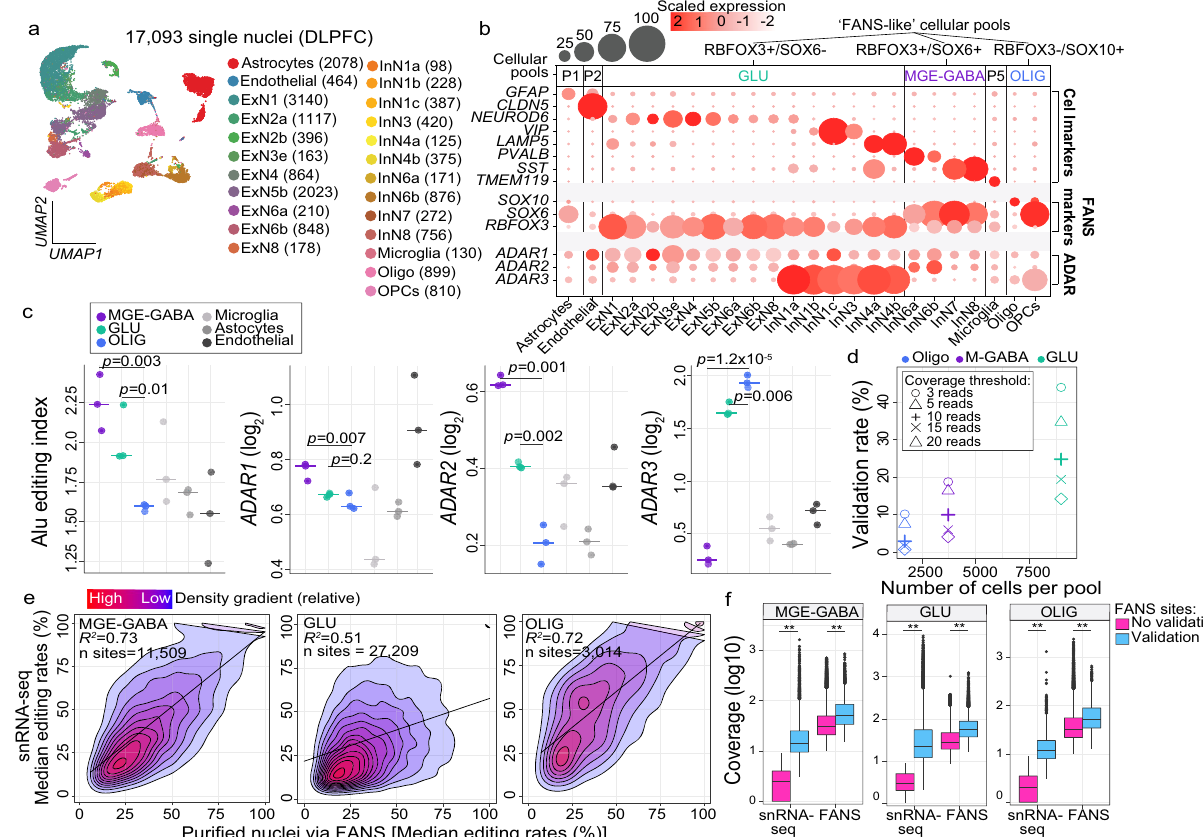
Fig. 4 Con fi rmation of cell-speci fi c editing in snRNA-seq. a snRNA-seq performed on adult PFC ( n = 3 biologically independent samples) classi fi ed 24 unique cell populations. Values in brackets indicate the number of cells per sub-population, including all excitatory (ExN) and inhibitory (InN) neuronal subsets. b Cells were collapsed into six major cellular pools (P) and evaluated for expression of canonical marker genes and FANS-derived cell populations ( RBFOX3 , SOX6 , and/or SOX10 ), which were used to de fi ne ‘ FANS-like cellular pools ’ . c The AEI and expression pro fi les for ADAR1 , ADAR2 , and ADAR3 (y- axes) were computed for each ‘ FANS-like cellular pool ’ in addition to microglia, astrocytes, and endothelial cells. Two-sided regression analyses were used to compute signi fi cance between MGE-GABA vs. GLU and GLU vs. OLIG populations and associations with p < 0.05 were deemed signi fi cant. Data were presented as mean values ± SEM. No adjustments were made for multiple comparisons. d The percentage of editing sites (y-axis) from the original FANS- derived cell populations ( n = 9 biologically independent samples) that validate in each respective ‘ FANS-like pool ’ was determined across varying read coverage thresholds. e Concordance of median editing levels (%) within each cell type for sites validated by FANS and snRNA-seq. f Sites which failed to validate by snRNA-seq were explained by a difference in read coverage and the total number of cells sequenced. All box plots show the medians (horizontal lines), upper and lower quartiles (inner box edges), and 1.5 × the interquartile range (whiskers). Two-sided Mann – Whitney U -tests were used computed signi fi cance in mean differences in read coverage differences between sites with and without validation and associations with a p value <0.05 (denoted with double asterisks) were deemed signi fi cant. Exact p values are provided in Supplementary